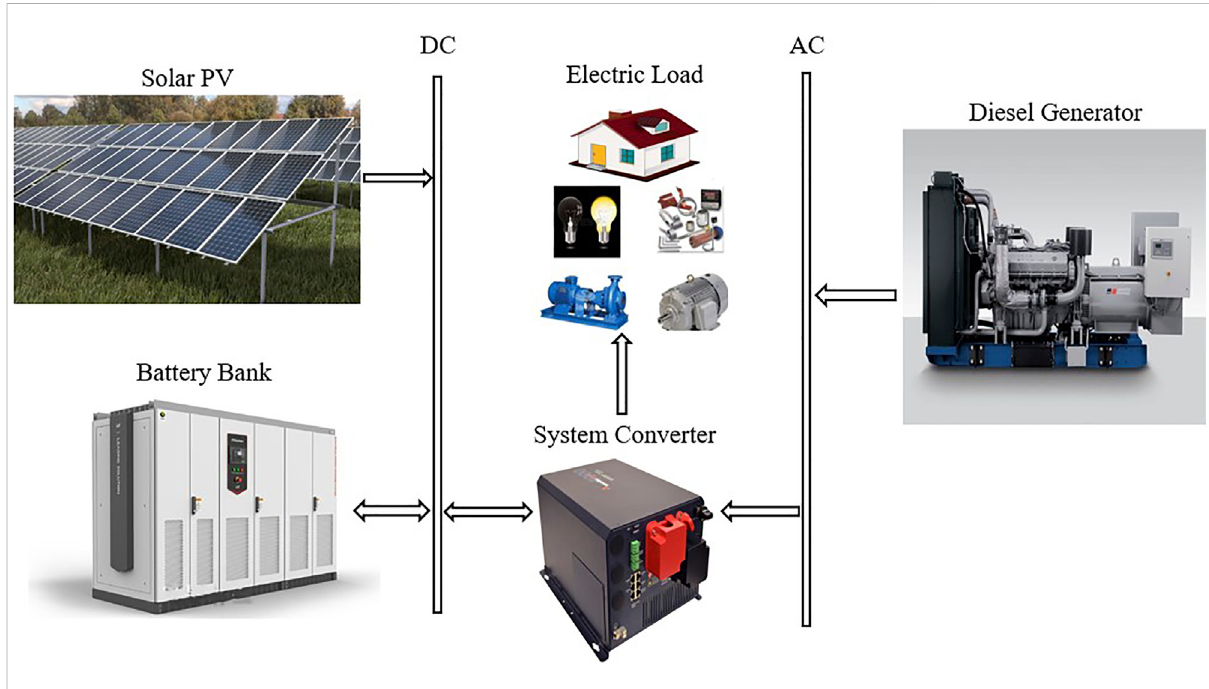
FIGURE 1 Schematics of the proposed hybrid